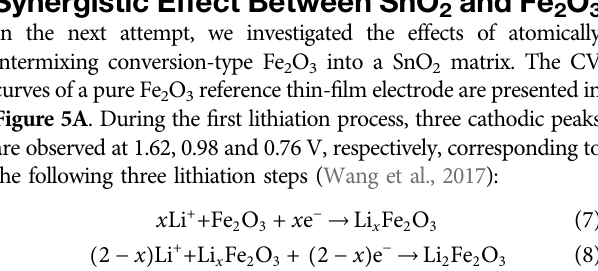
Frontiers in Energy Research |